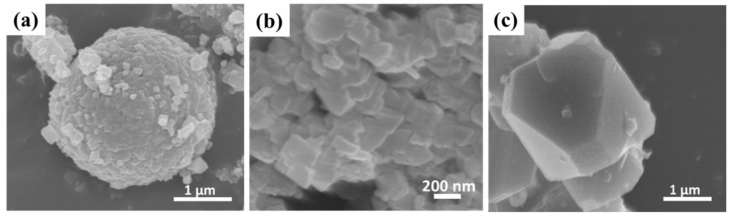
Figure 2. SEM images of ( a , b ) polycrystalline LiMn 2 O 4 and ( c ) single-crystal LiMn 2 O 4 .